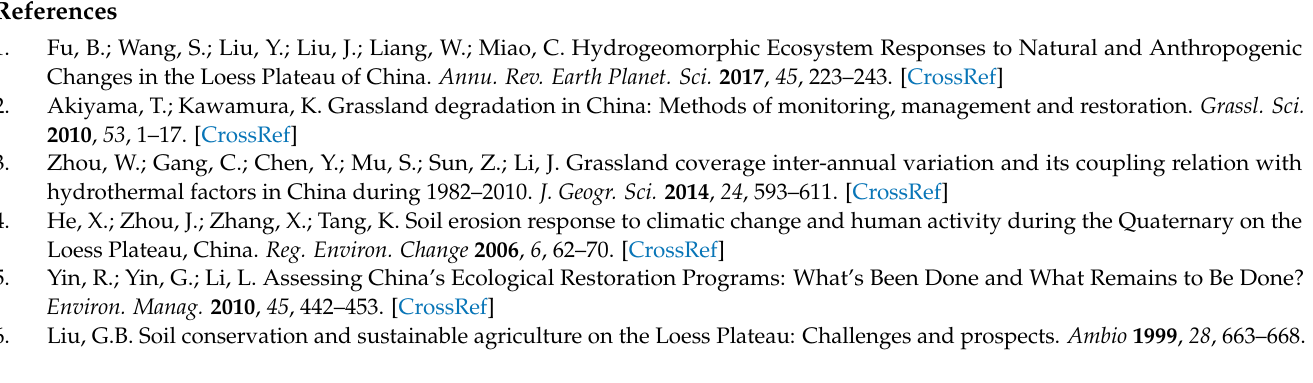
Table S2: The area of suitable habitats (before and after optimization) of apple trees on the Loess Plateau (104 × km2). The CUH represents the class unsuitable